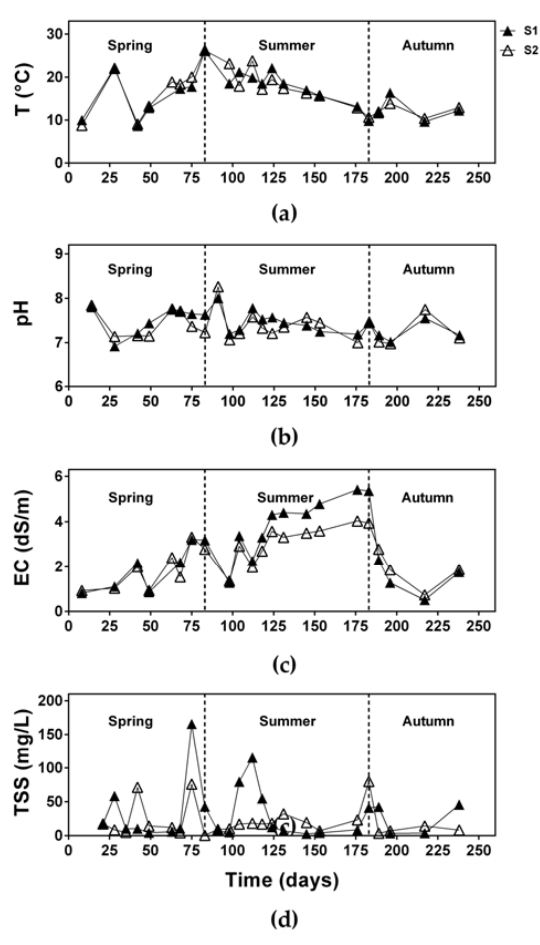
Figure 8. Water quality indicators in influent (S1) and effluent (S2) surface water along the monitoring performed in the pilot site from spring to autumn 2012: ( a ) temperature (T); ( b ) pH; ( c ) electrical conductivity (EC) and ( d ) total suspended solids (TSS).